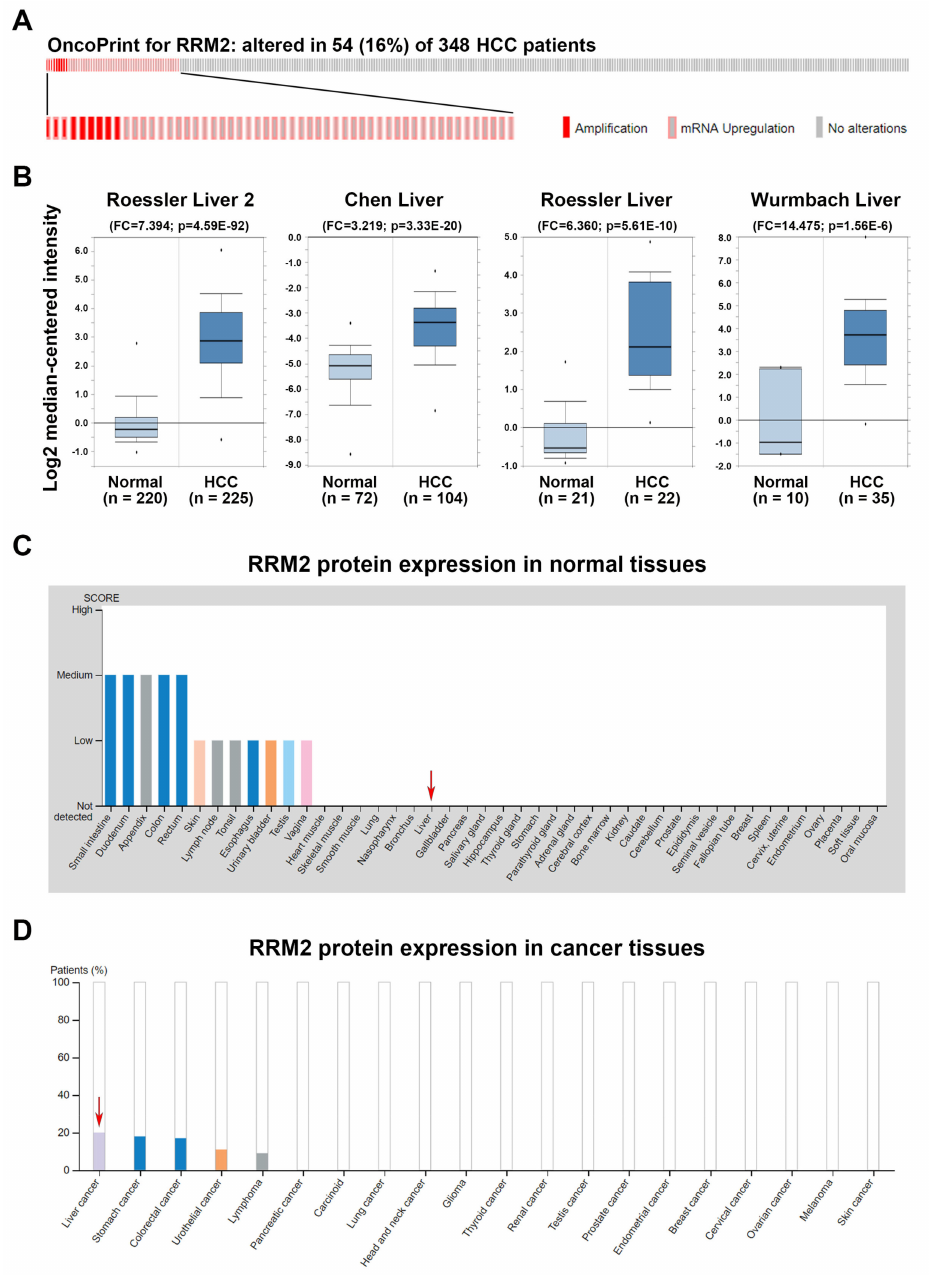
Figure 2. Ribonucleotide reductase regulatory subunit M2 (RRM2) expression in hepatocellular carcinoma (HCC). ( A ) A bar code plot (OncoPrint) for mutation status, copy number alterations, and mRNA expression of RRM2 gene in HCC were analyzed using the cBioPortal cancer genomics database. ( B ) RRM2 mRNA expression in tumor and normal tissues from HCC patients was analyzed using the Oncomine database. ( C , D ) RRM2 protein expression in normal ( C ) and tumor ( D ) liver tissues (highlighted by red arrows). Image credit: Human Protein Atlas. Data summary images were obtained from v19.proteinatlas.org, via the following links: https: // www.proteinatlas.org / ENSG00000171848-RRM2 / tissue for ( C ) and https: // www.proteinatlas.org / ENSG 00000171848-RRM2 / pathology for ( D